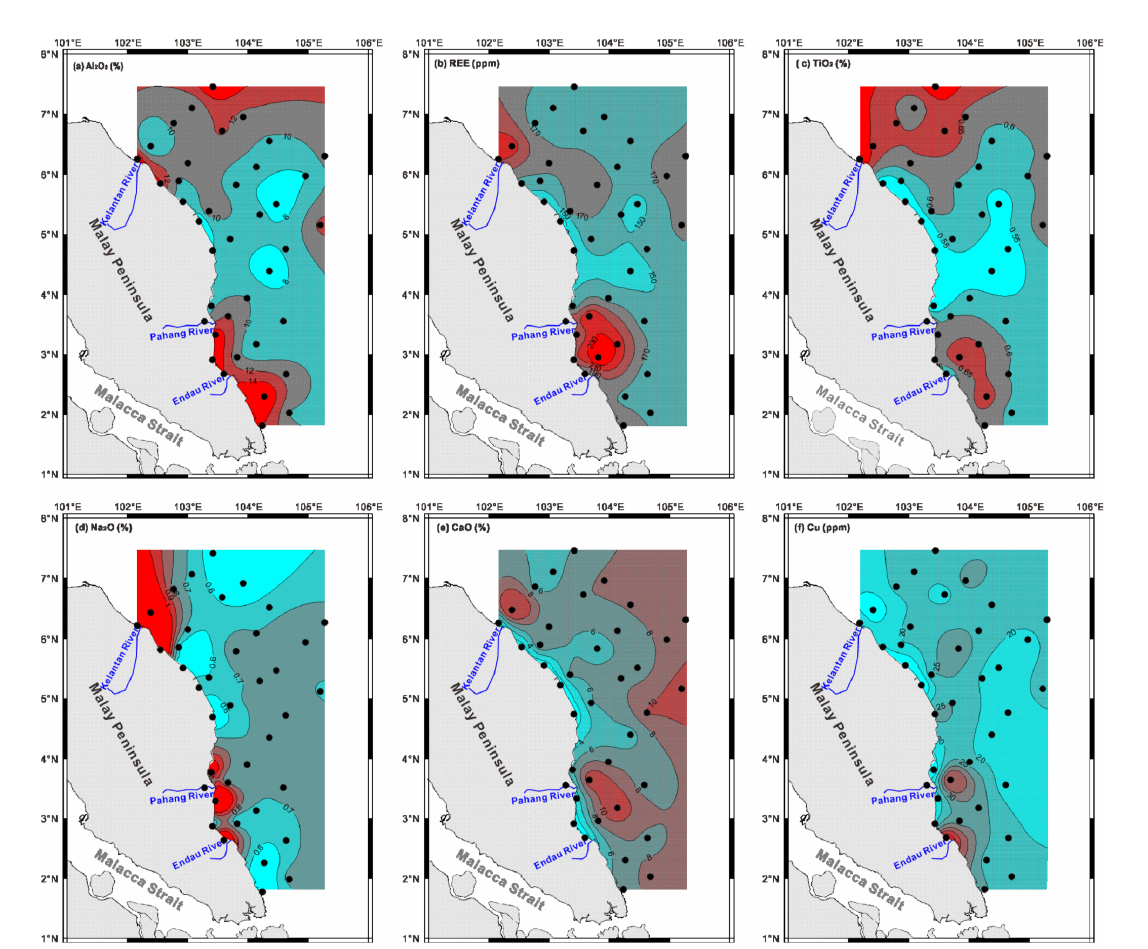
Figure 4. Locations of surface sediment types (dark dots) and the distributions of selected elements in eastern Malaysia and on the neighbouring Sunda Shelf. ( a ) Al 2 O 3 , ( b ) rare earth elements (REEs), ( c ) TiO 2 , ( d ) Na 2 O, ( e ) CaO, and ( f ) Cu. REEs and Cu in ppm, other components in